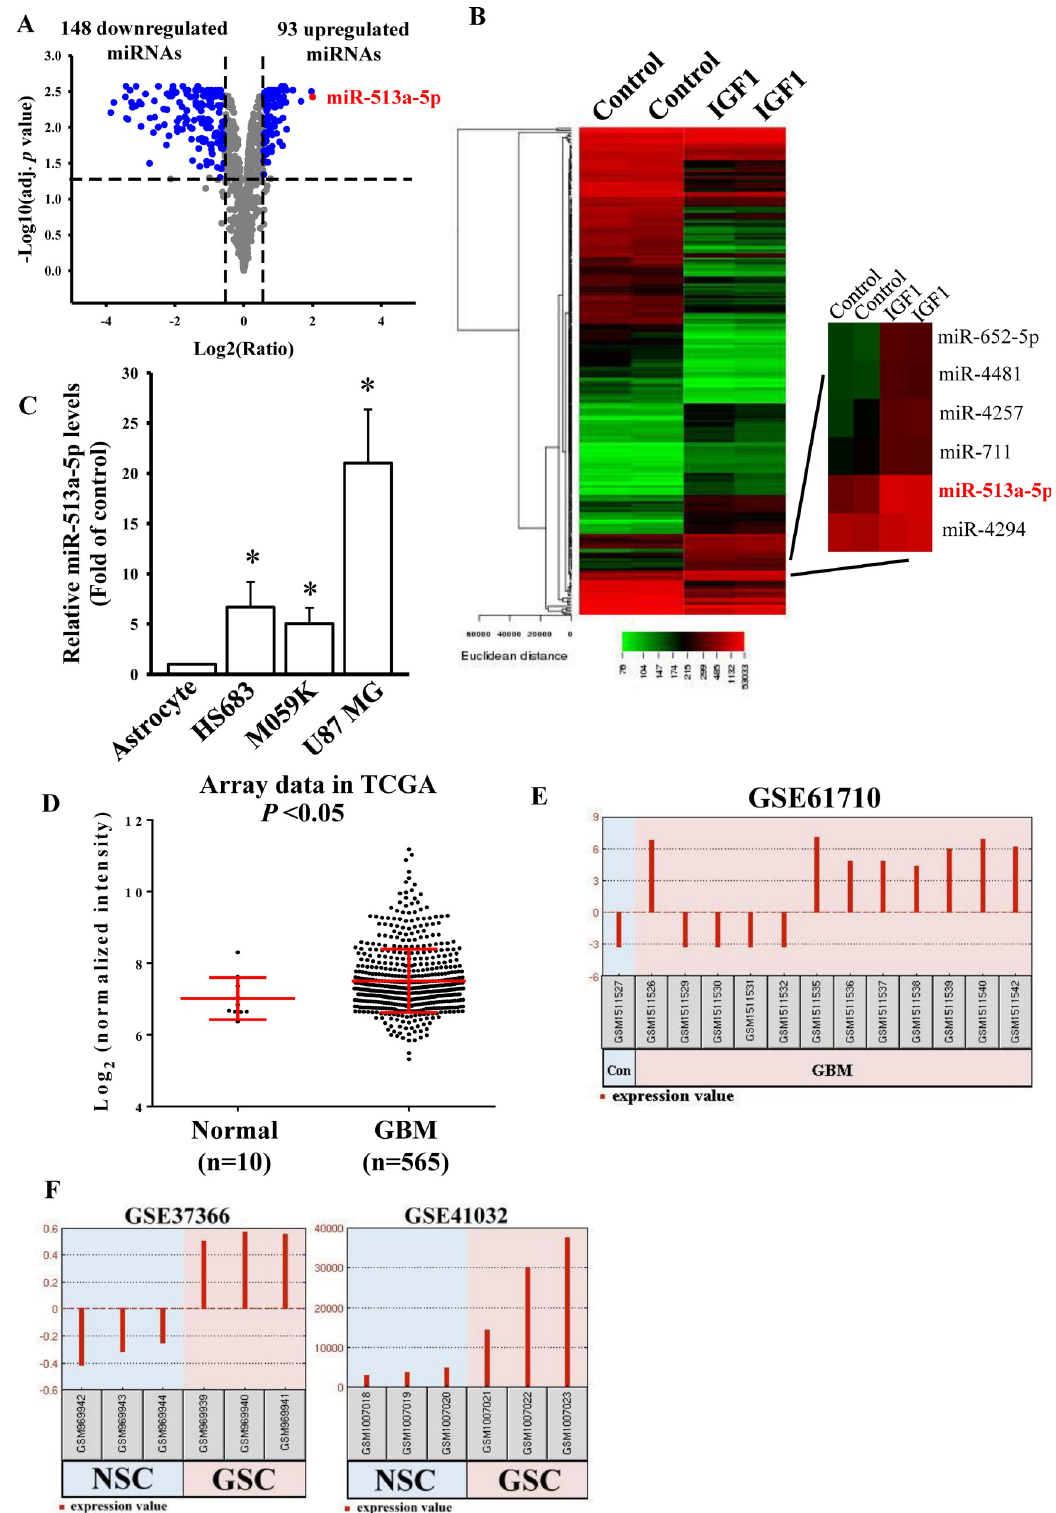
Fig 2. Significant upregulation of microRNA (miR)-513a-5p in insulin-like growth factor (IGF)-1-treated glioma cells. Volcano plot (A) and heat map of hierarchical gene clustering (B) demonstrating IGF-1-regulated microRNA profiles. After